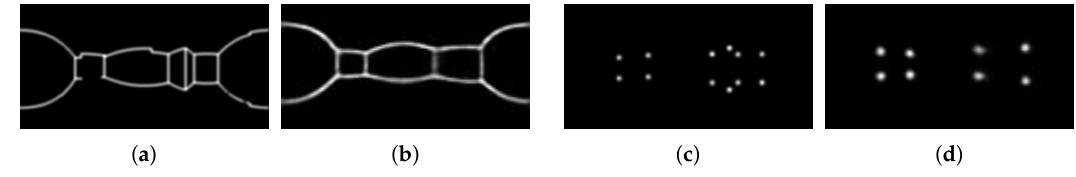
Figure 8. Results of CFL using a synthetic image from a 6-wall environment. ( a ): Edges ground truth; ( b ): Edges output from CFL; ( c ): Corners ground truth; ( d ): Corners output from CFL.